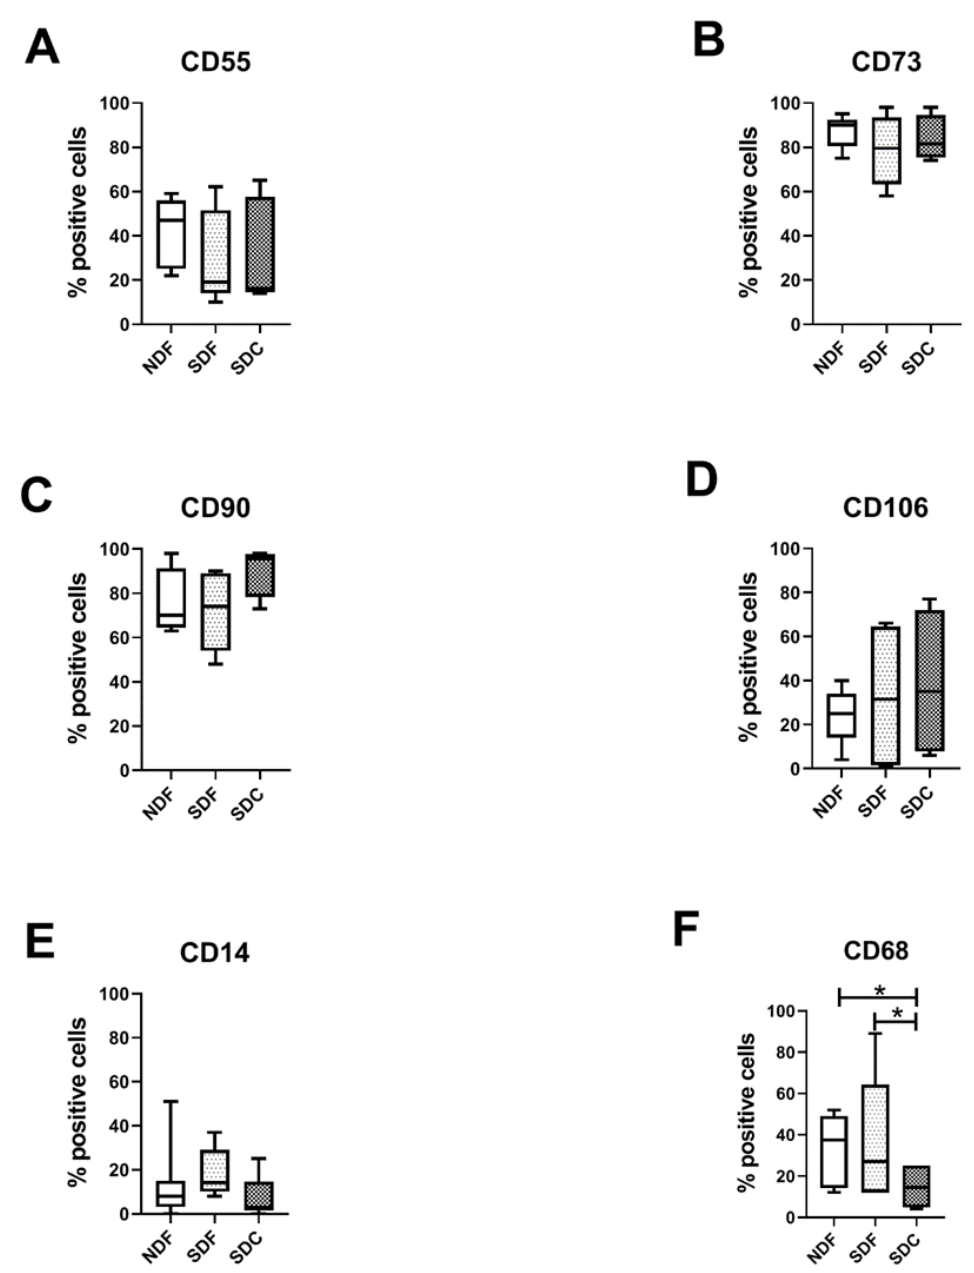
Figure 3. Flow cytometry evaluation of markers of synovial fibroblasts and macrophages. CD55 ( A ), CD73 ( B ), CD90 ( C ), and CD106 ( D ) typical markers of synovial fibroblasts evaluated on cells obtained with NDF, SDF, and SDC isolation procedures ( n = 8). CD14 ( E ) and CD68 ( F ) typical markers of synovial macrophages evaluated on cells obtained with NDF, SDF, and SDC isolation procedures. Data are expressed as percentage of positive cells and represented as box plots with median, minimum and maximum. Significant results among groups (* p < 0.05) were reported (Dunn’s for multiple comparisons test).